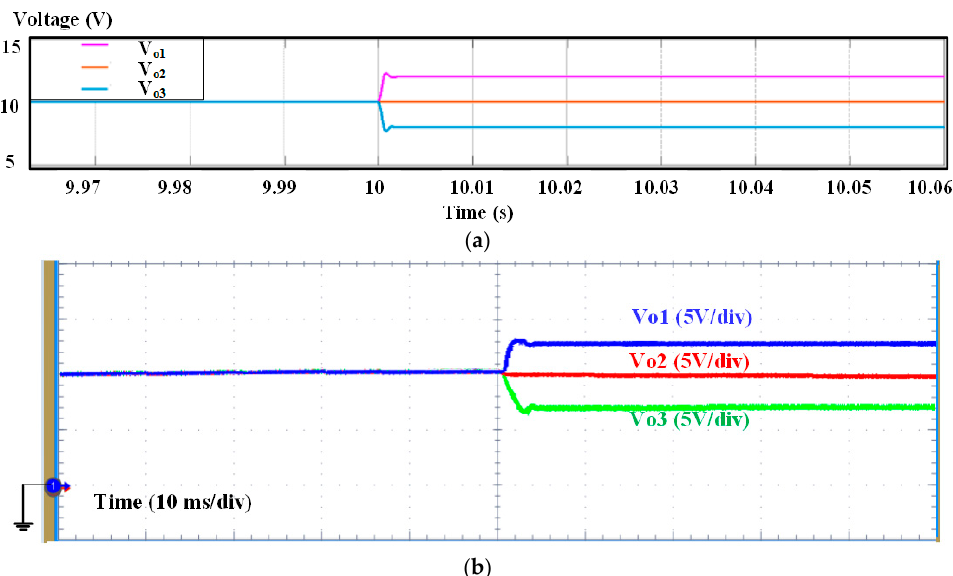
Figure 10. Waveforms for three battery module output voltage when SOC values of three modules changed from SOC 1 = SOC 2 = SOC 3 = 70% to SOC 1 = 75%, SOC 2 = 70%, and SOC 3 = 65%, ( a ) simulation results and ( b ) hardware experimental results.